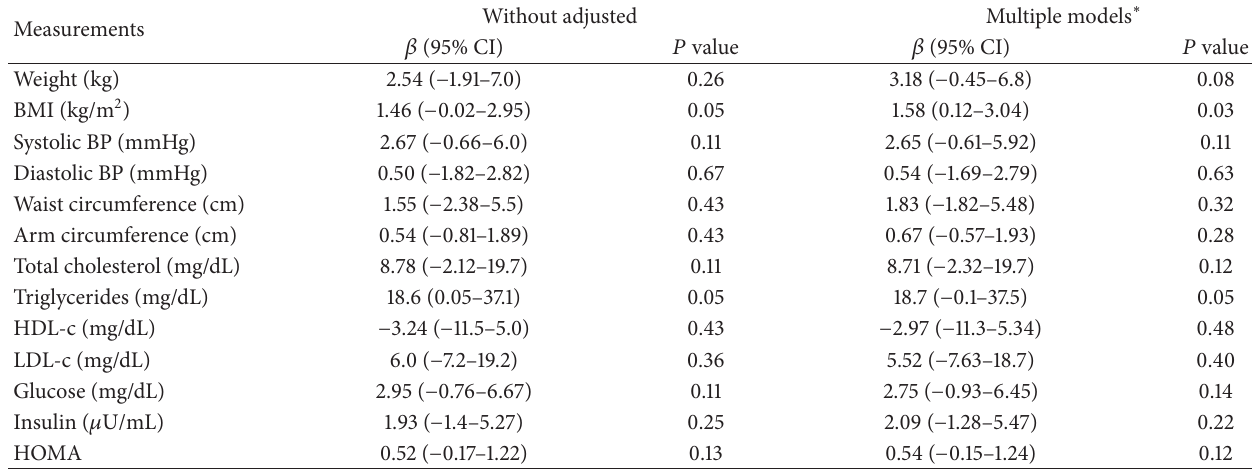
Table 2: Effect of Ad-36 seropositivity on clinical and biochemical measurements.